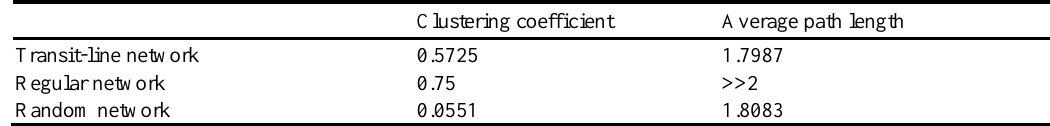
Table.1 Topological parameters of transit-line network comparing with regular network and random